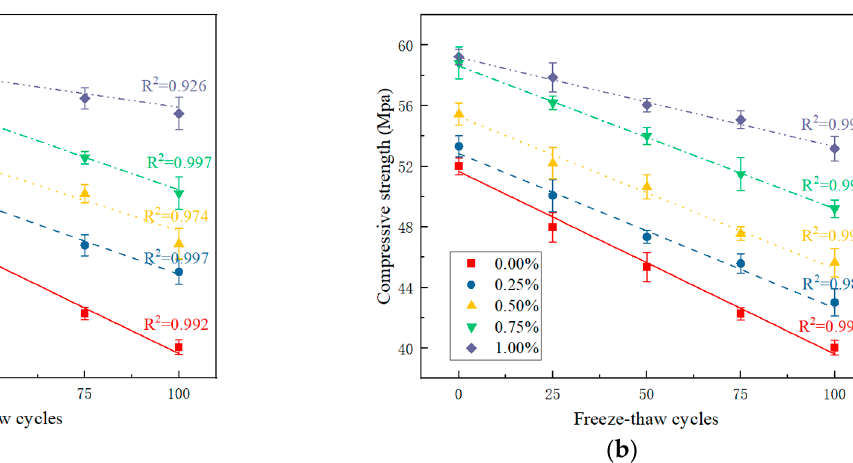
Figure 9. Fitting curve of the compressive strength of PRGRC with the number of freeze-thaw cycles: ( a ) 6 mm POM fiber; ( b ) 12 mm POM fiber.